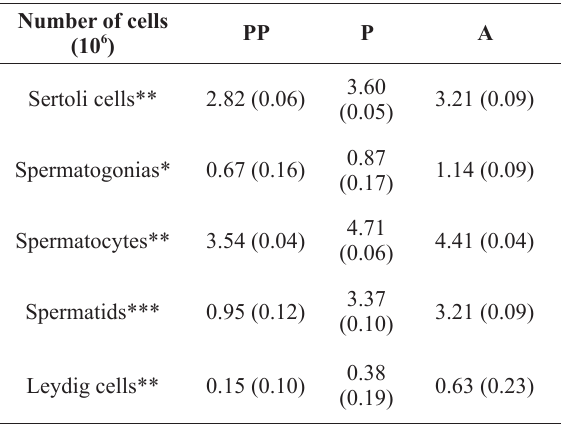
The mean values of the total number of Sertoli cells, spermatogonia, spermatocyte, spermatid and Leydig cells in cutia.